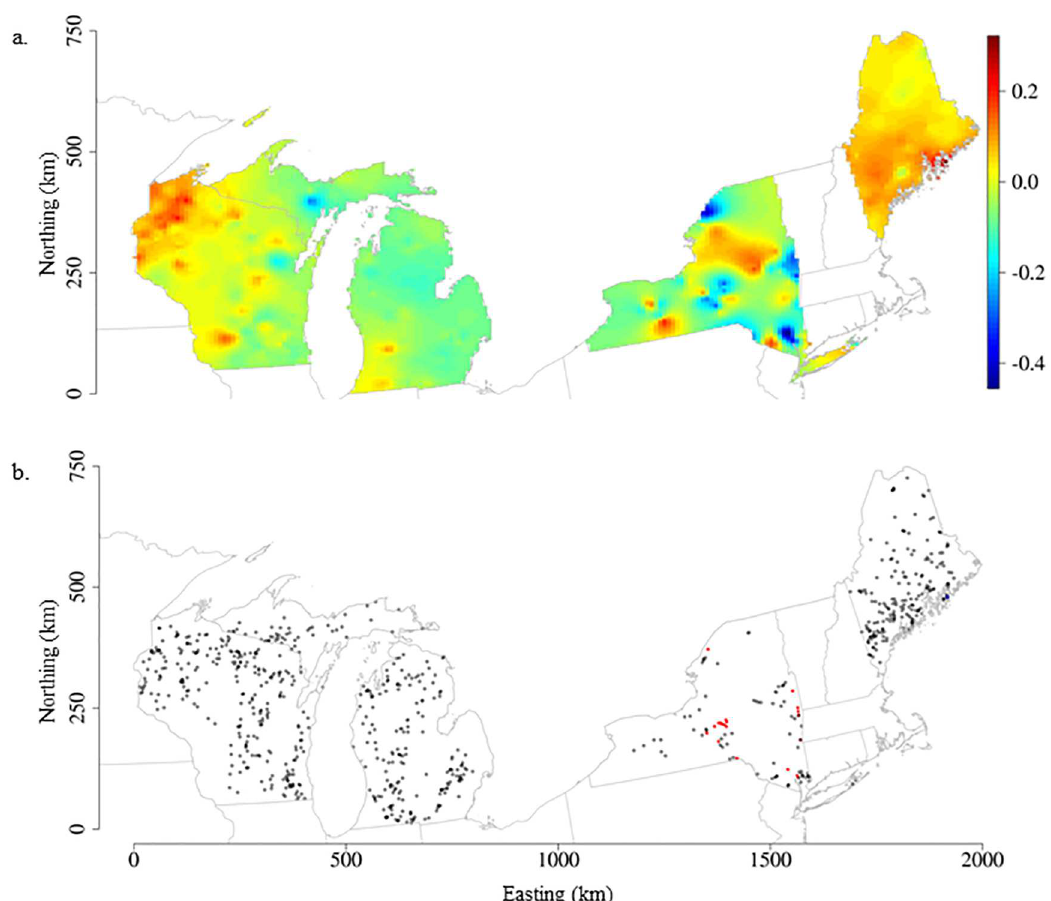
Fig 4. Spatially-varying water color–CHL coefficients maps derived from the SVC FULL model. a) Surface map of spatially-varying water color–CHLrelationships created by interpolation of the posterior mean values that were estimated by lake location in the model buildingdataset (N = 779). Blue to red color gradientrepresents low to high water color–CHL coefficient values. b) Map of lake point locationssymbolizedby water color–CHLrelationships: positive (blue), negative (red), not significant (black outlined dot). Significant relationships were determinedbased on 95% credible intervals not overlapping zero.